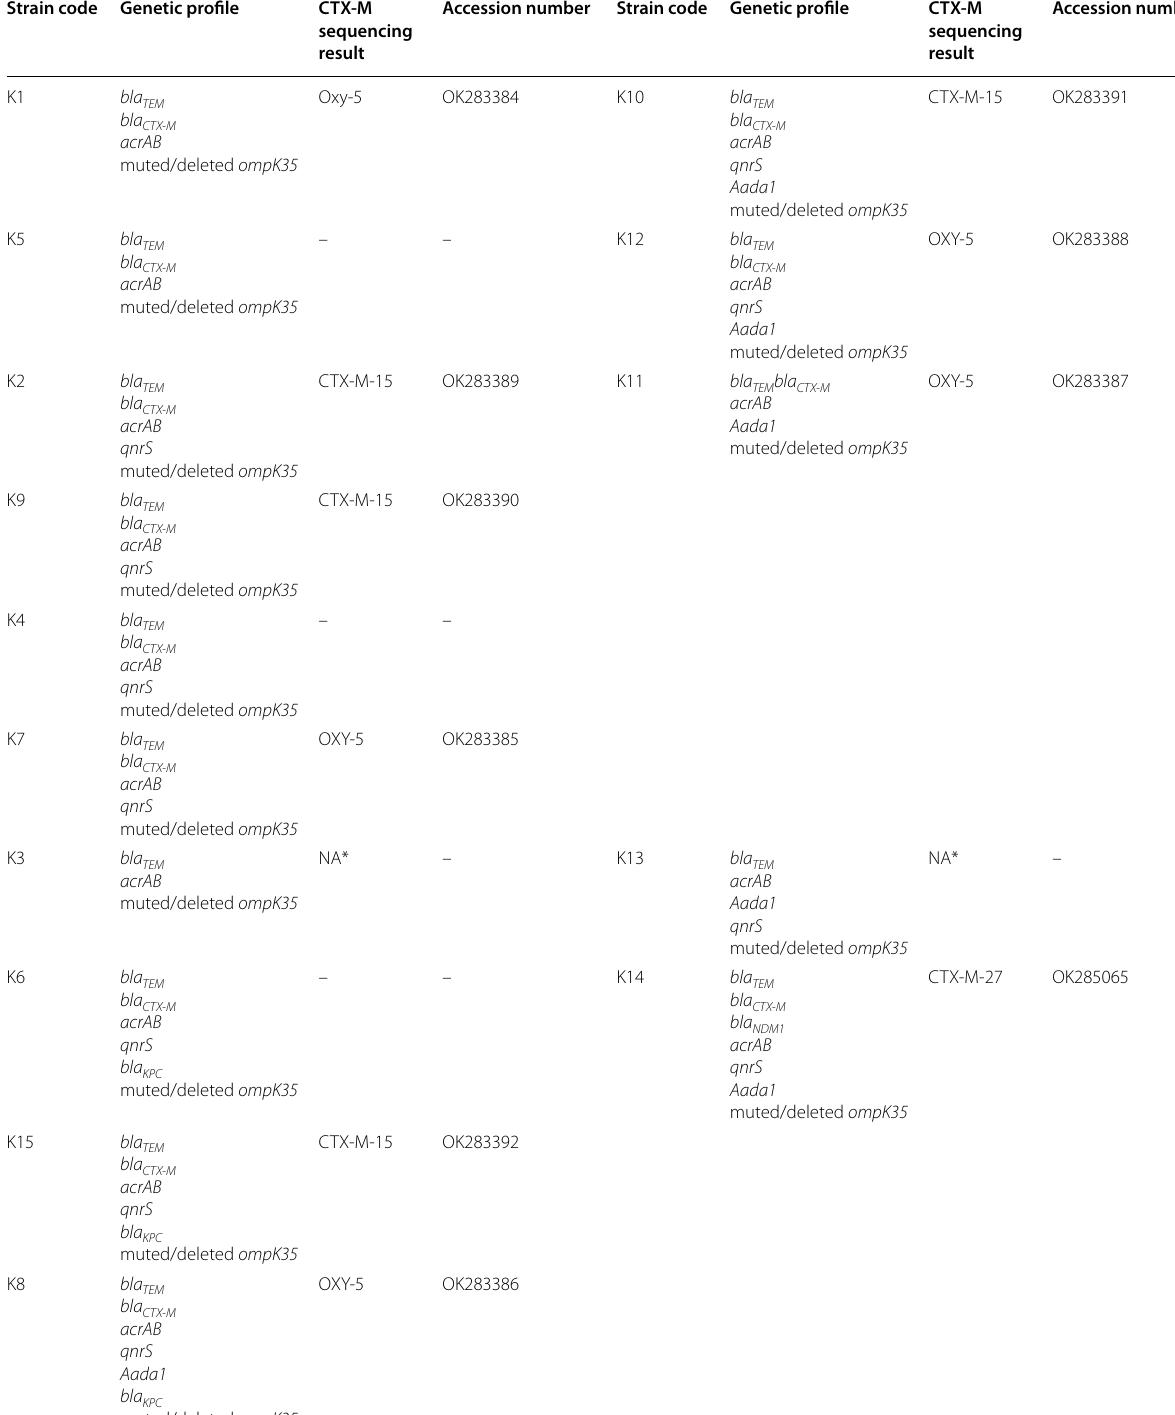
Table 2 Genetic profile of the K. pneumoniae